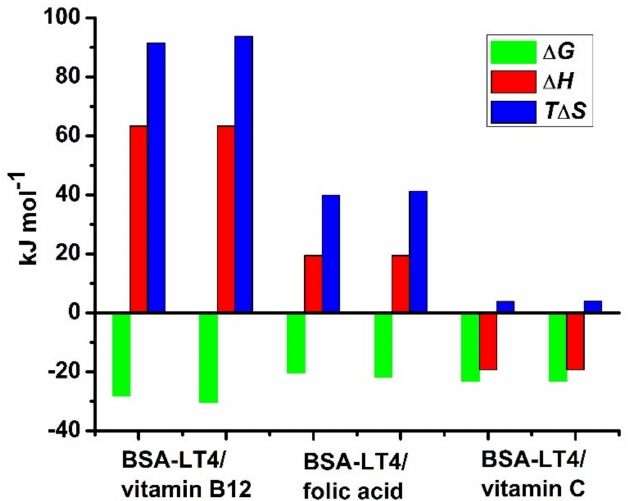
Figure 5. The thermodynamic parameters for the binding of the vitamin B12, vitamin C and folic acid with BSA.